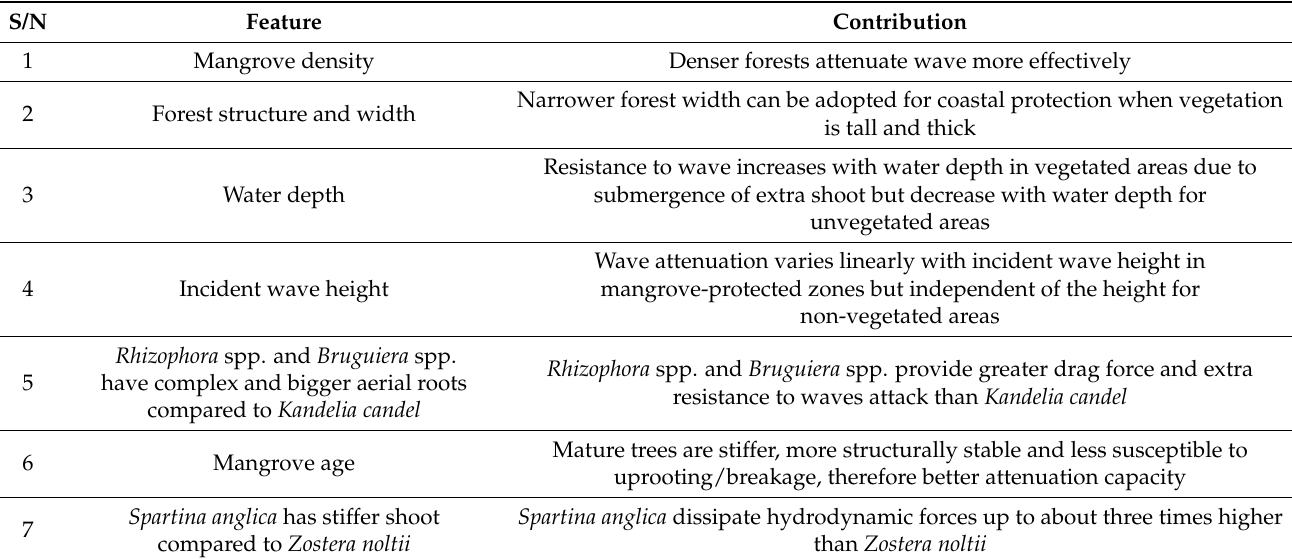
Table 1. Summarised list of the mangrove characteristics/hydraulic conditions and their contribution towards wave